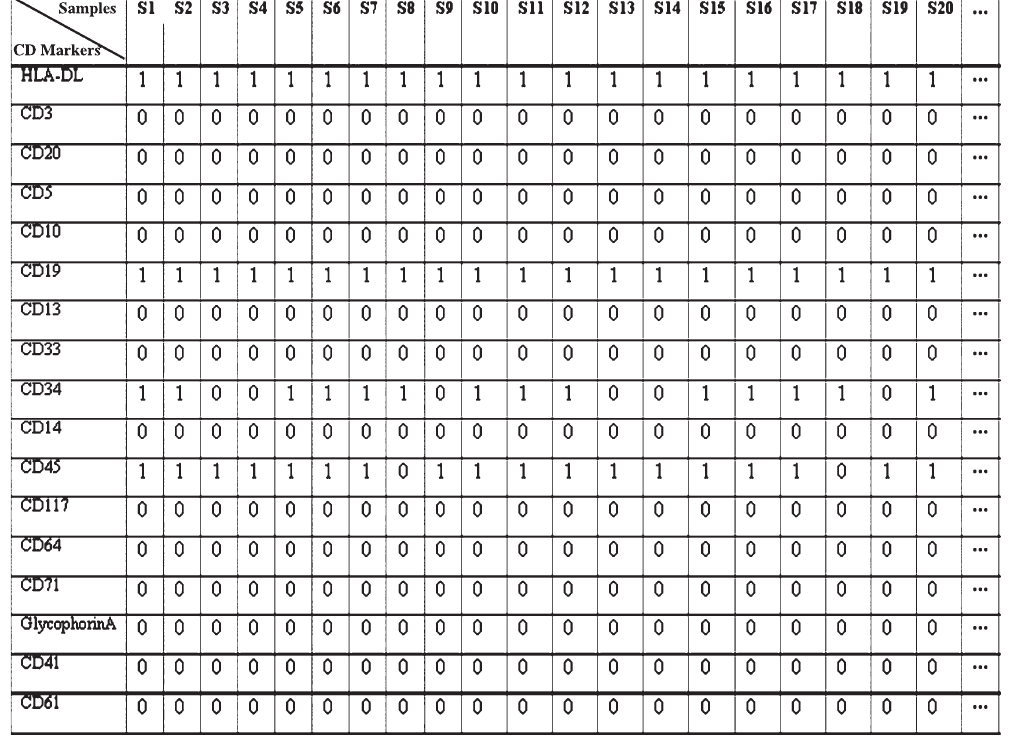
Fig. 4. Conversion N × Mmatrix of Pro B